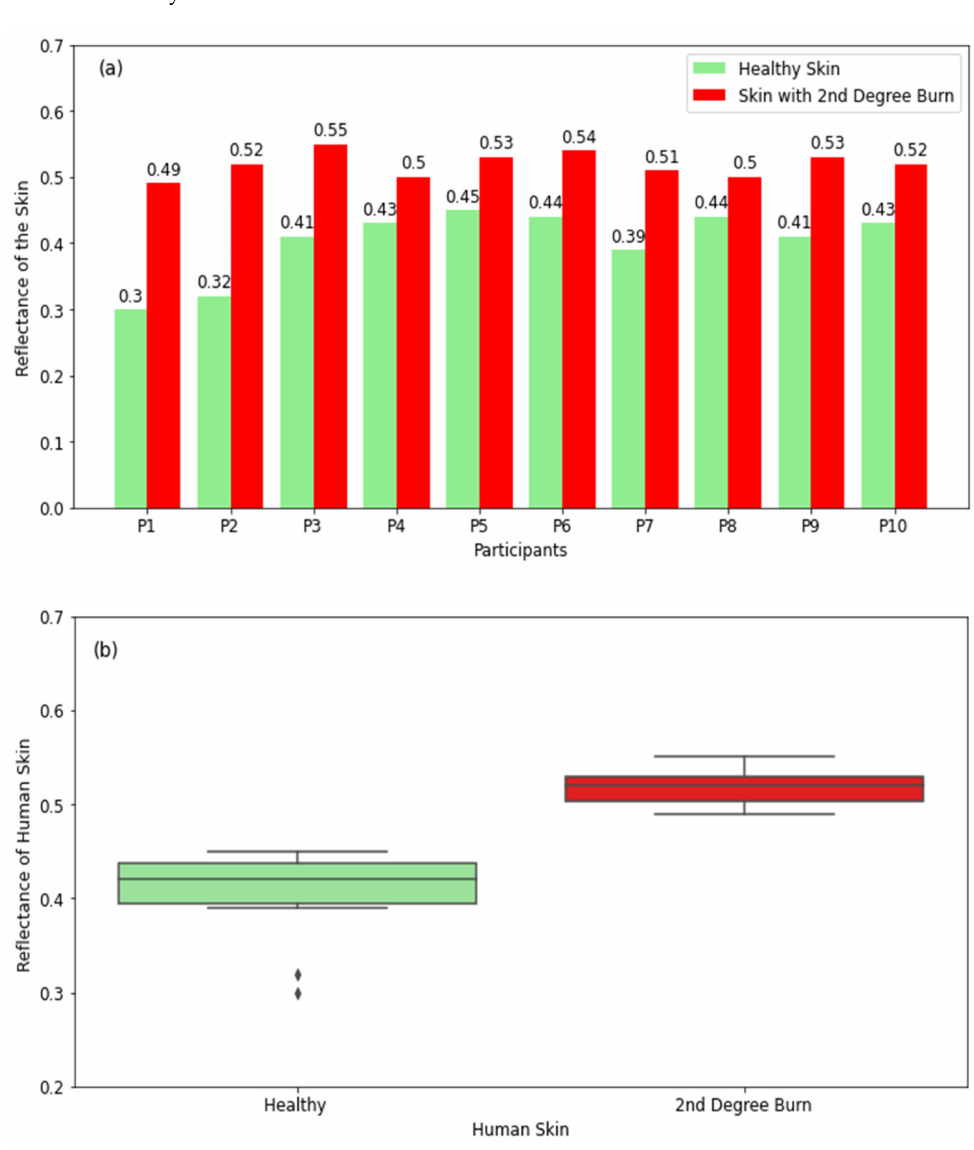
Figure 6. Reflectance measurements in a sample of 10 participants with 2nd-degree burns compared with the closest region of unburned skin on the same participant ( a ). The boxplot shows the range of the reflectance of healthy skin and 2nd-degree-burned skin ( b ). The symbol ( ♦ ) represents the